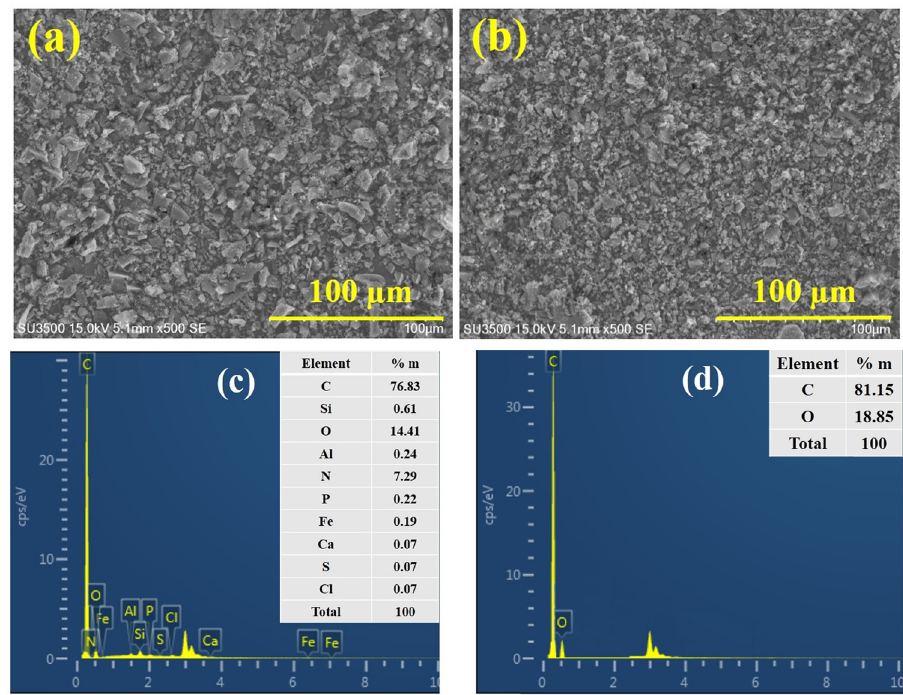
Figure A2: SEM images of ( a ) AC, ( b ) mAC, and EDX of ( c ) AC, ( d ) mAC.